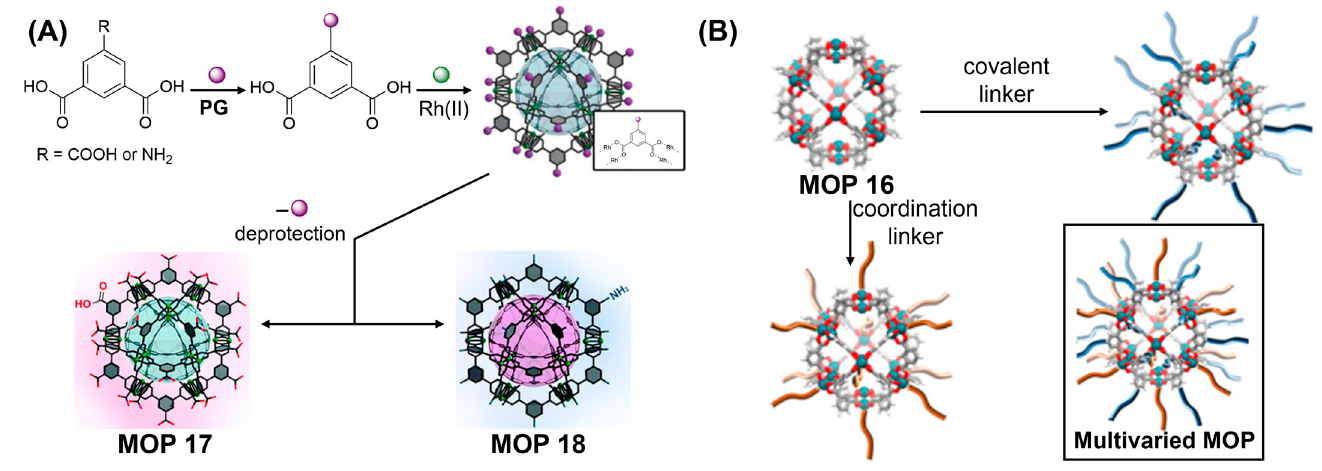
Figure 11. ( A ) Scheme of protecting group strategy to synthesize COOH-tagged cuboctahedron Rh(II)-based MOP 17 and NH 2 -tagged Rh(II)-based MOP 18. ( B ) Post-synthetic covalent and coor- dination modification of cuboctahedron MOP 16. (Inset) Illustration of a cuboctahedron Rh-MOP functionalized on the 12 dirhodium paddlewheels through coordination chemistry (in orange) and on the 24 organic linkers through covalent chemistry (in blue). Reprinted by permission from Refs. [123,127]. Copyright 2019 from Royal Society of Chemistry and copyright 2019 from American Chemical Society.